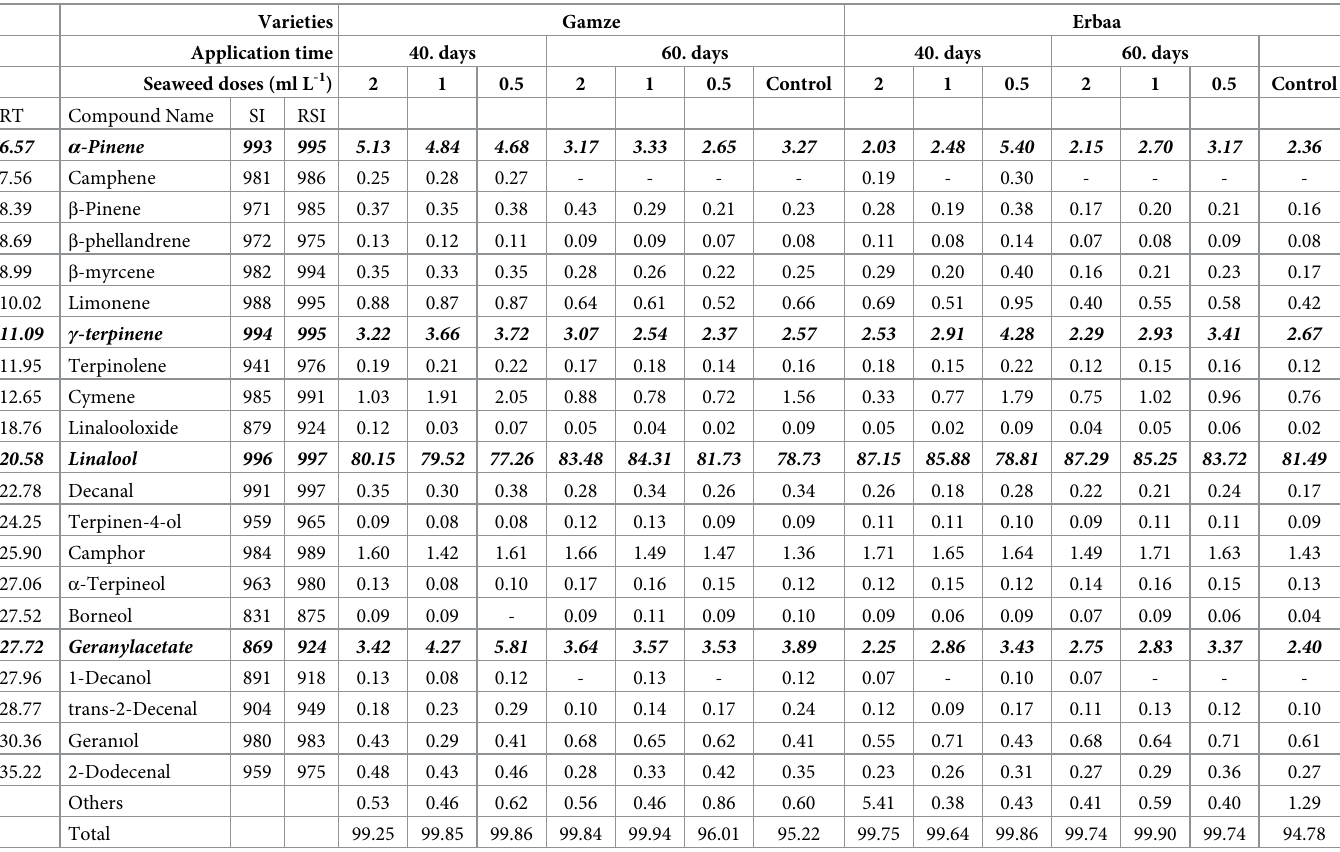
Table 7. Essential oil ratios of the two coriander varieties applied with different seaweed doses at different times (day 40 and day 60) at location B.